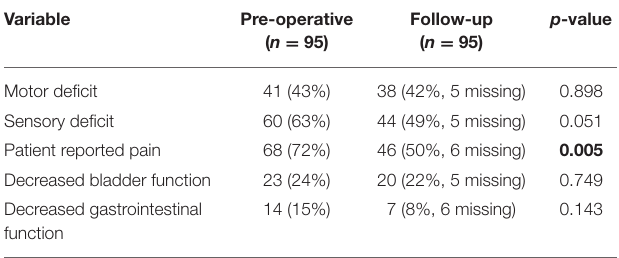
TABLE 5 | Functional